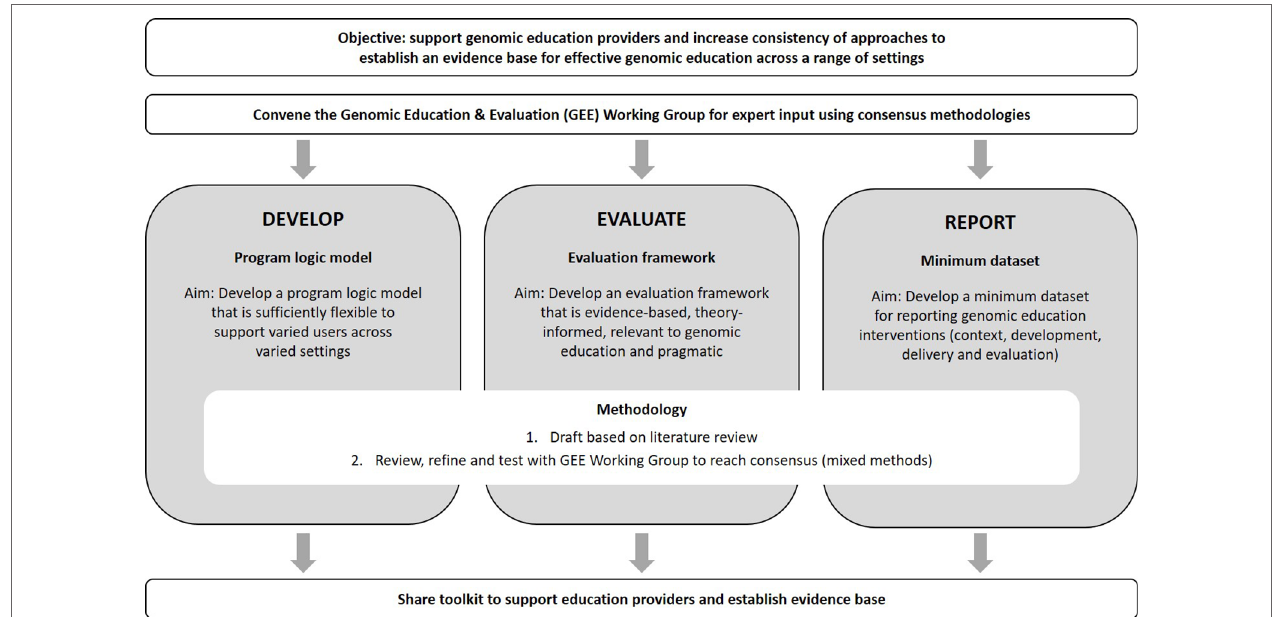
FIGURE 1 | Summary of the Australian Genomics Workforce & Education “Effective Education” program of